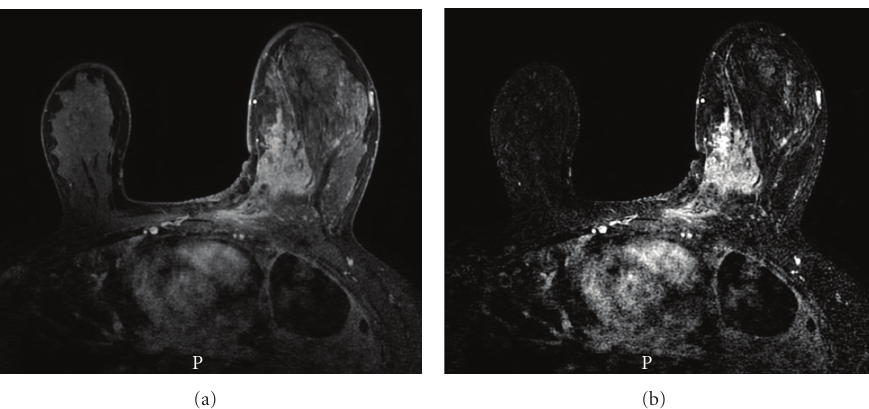
Figure 1: (a, b) Breast MRI demonstrated regional enhancement in the left superior breast extending to the chest wall and di ff use skin thickening.